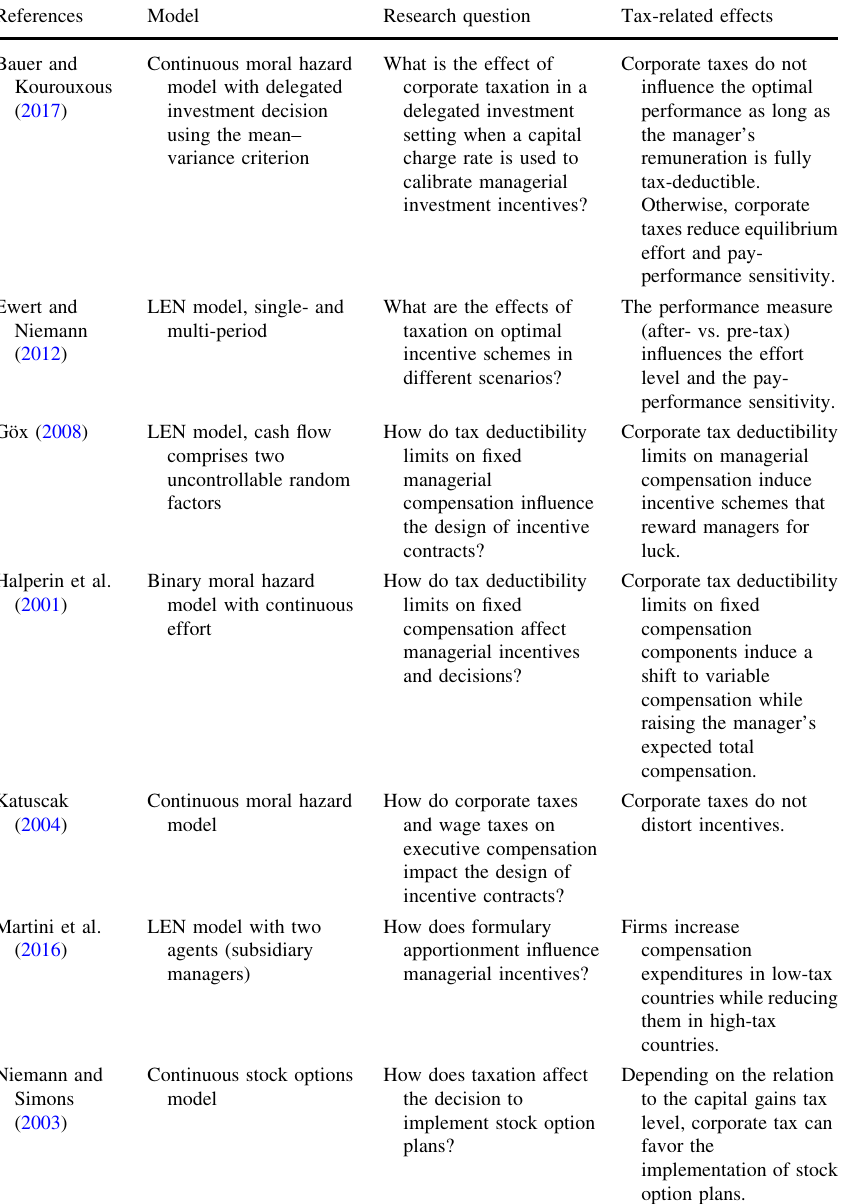
Table 2 Corporate taxes and the design of compensation